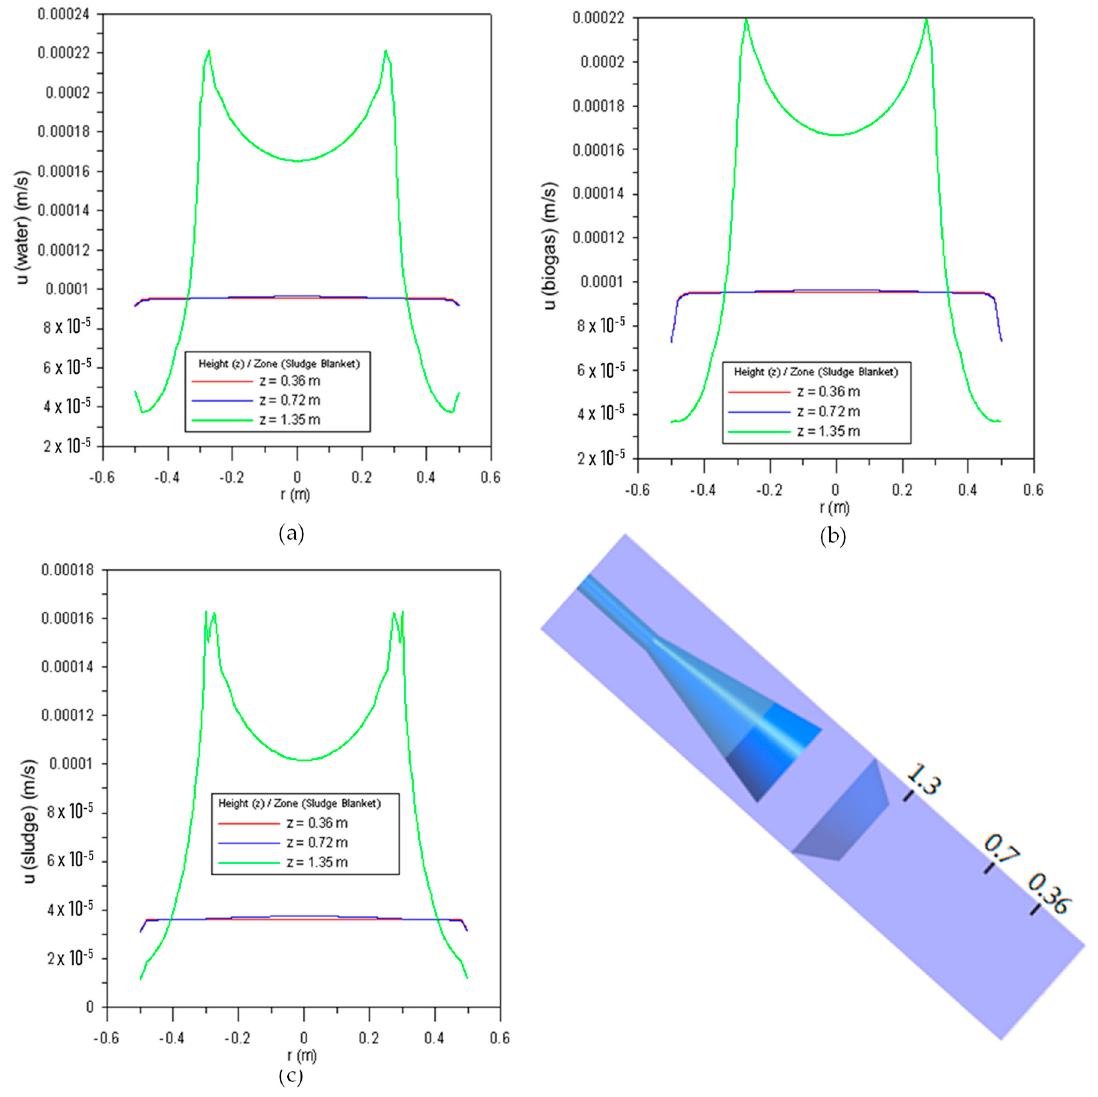
Figure 13. Distribution of the resulting velocity according to the radial position for different axial positions, z, on the sludge blanket region (downward inclination of the deflector): ( a ) water, ( b ) biogas, and ( c ) sludge.